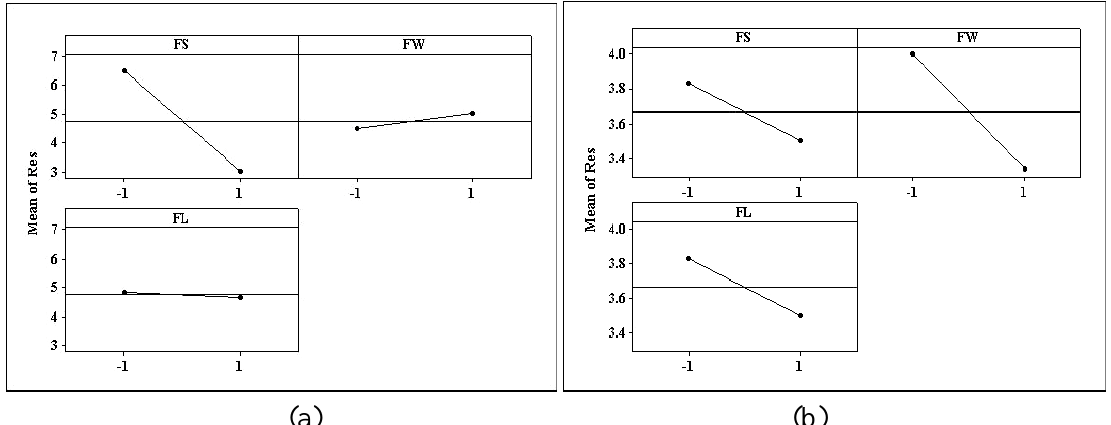
Figure 3. Main effect plots of the three factors (FS, FW, FL) on the response sensitivity for two different films: (a) NDT-Au